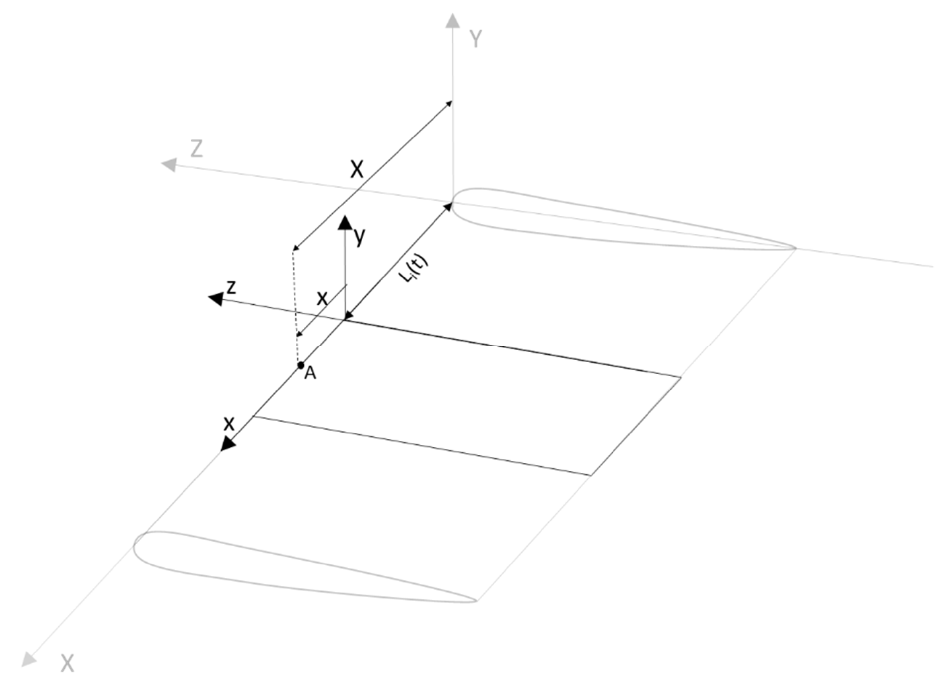
Figure 5. An element in the cantilever beam.